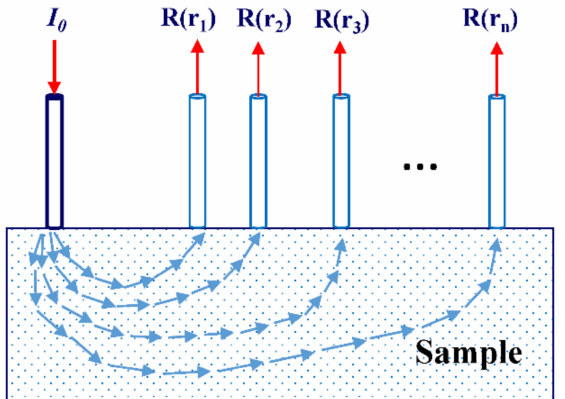
Figure 1. The configuration of single-fiber scanning and the “banana-shape” path of light propagation in the